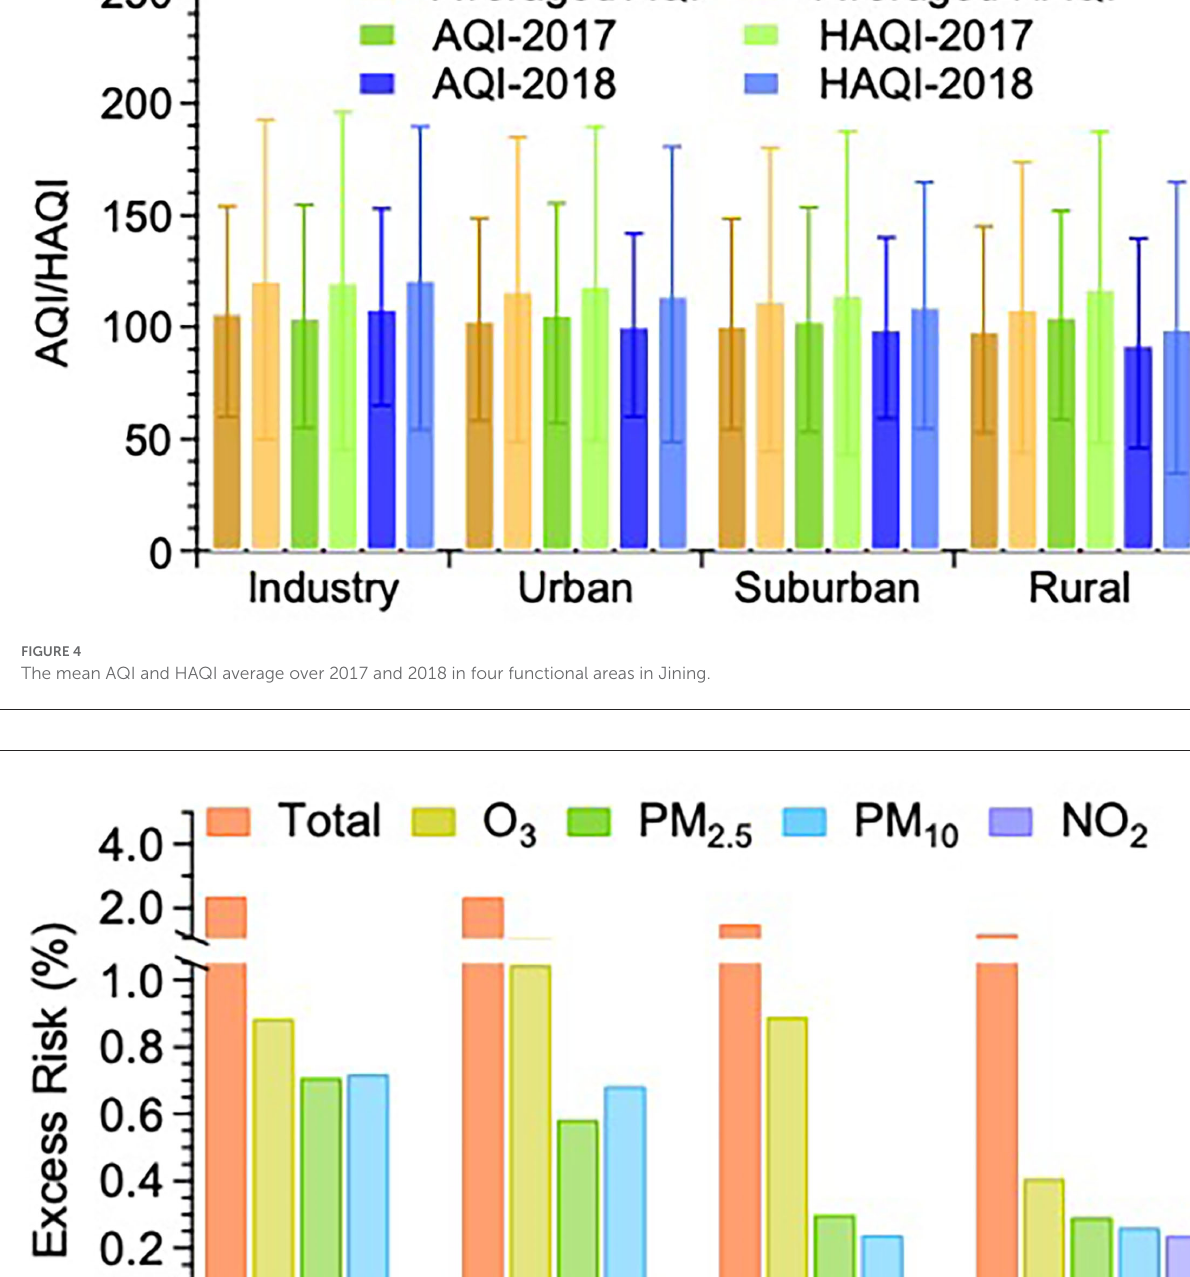
and IA, the contribution rate of PM 10 decreased from 29.6 and 31.7% in 2017 to 19.5 and 23.6% in 2018, while PM 2.5 increased from 28.63 and 19.9% in 2017 to 31.2 and 36.2% in 2018,